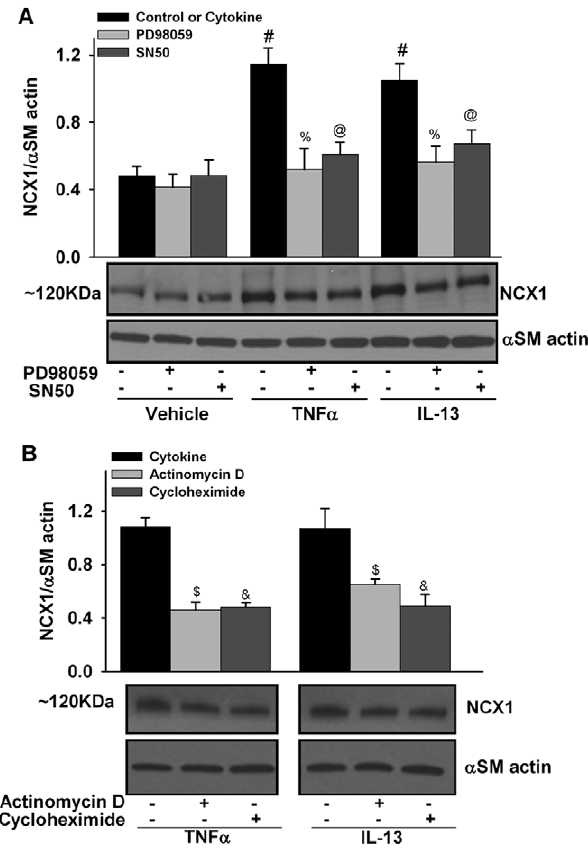
Figure 2. Mechanisms of cytokine-induced increase in NCX1 expression. A. Pre-exposure of ASM cells to 20 m M SN50 (NF- k B inhibitor) or 5 m M PD98059 (MEK1/2/ERK1/2 MAP kinase inhibitor) 1 h prior to TNF a or IL-13 exposure (24 h, in continued presence of inhibitor) blunted cytokine-induced increase in NCX1 expression (120KDa) compared to controls not exposed to cytokines. B. In separate sets of cells, pre-exposure of ASM cells to the protein synthesis inhibitor cycloheximide (1 m g/ml) or the transcription inhibitor actinomycin D (1 m g/ml) 1 hr prior to TNF a or IL-13 exposure (24 h, in continued presence of inhibitor) blocked NCX upregulation. a SM actin was used as loading control. Vehicle is culture media. Values are means 6 SE (n=4). # significant cytokine effect, % significant PD98059 effect, @